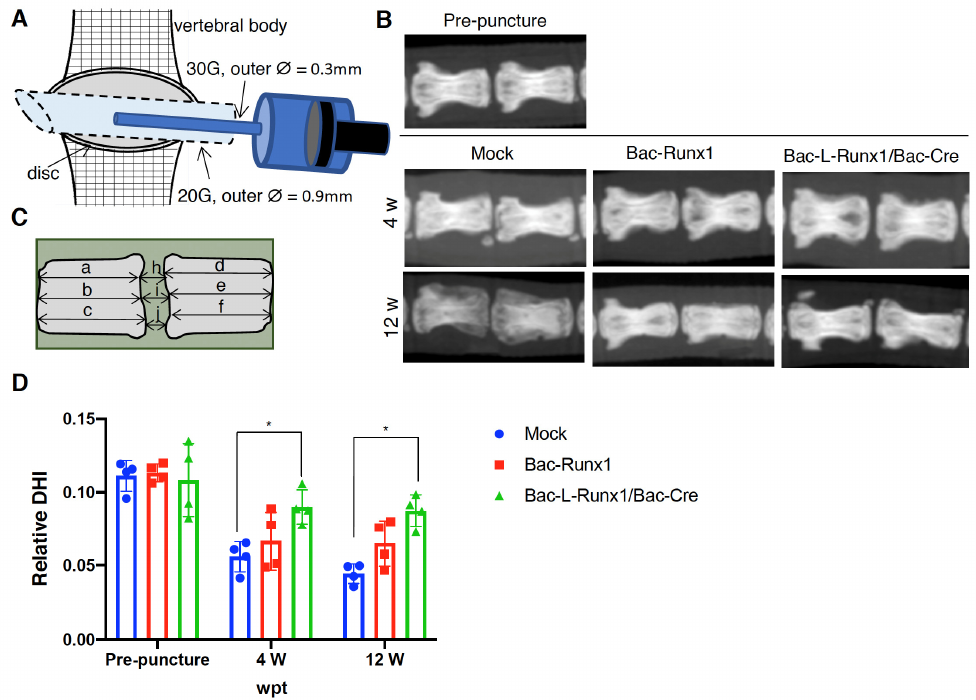
Figure 6. Radiographic images evaluate the disc height index (DHI) after grafting the recombinant BV transduced BMSCs in the punctured coccygeal disc in the rat. ( A ) Illustration of disc puncture and cells delivery method. ( B ) X-ray radiographic images showed the coccygeal disc height at BMSCs post-injection 4 w and 12 w compared with pre-puncture. ( C ) DHI measurement is illustrated. DHI = 2 × (h + i + j)/(a + b + c + d + e + f). ( D ) Change of relative DHI at recombinant BV transduced BMSCs post-injection. Relative DHI was represented as post-puncture DHI/pre-puncture DHI. ( n ≥ 3) * p < 0.05; p < 0.001, ∅ is diameter.